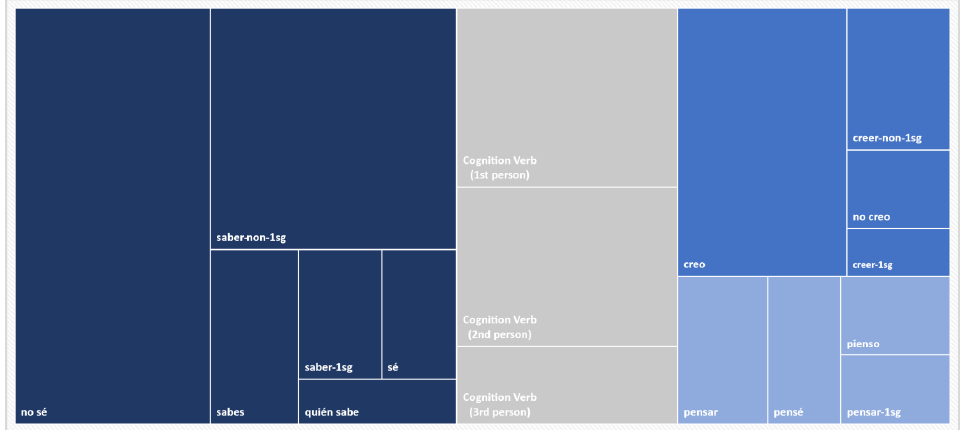
Figure 3. Distribution of cognition verbs by most frequent verb types and forms ( n = 720). The lexical makeup of cognition verbs is skewed: two thirds of cognition verb tokens are accounted for by two verb types, saber ‘to know’ and creer ‘to think’, and one third by two expressions, (yo) no s é ‘I don’t know’ and (yo) creo ‘I